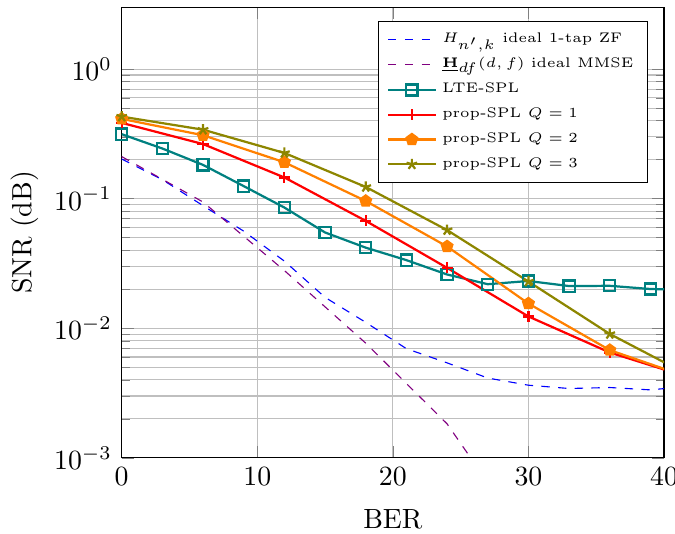
Figure 8. BER versus SNR under frequency-flat (single path) channel with Jakes Doppler spectrum for different channel estimation and equalization